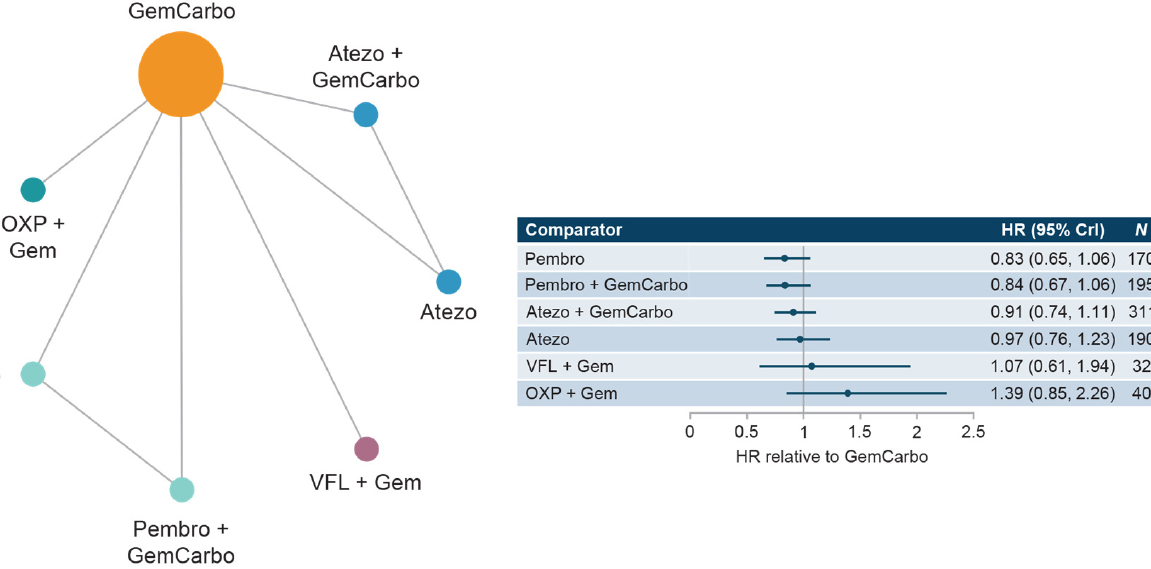
Figure 2. Network diagram and HR for OS by treatment network for the cis-ineligible (wide) net- work. Abbreviations: Atezo, atezolizumab; cis, cisplatin; CrI, credible interval; Gem, gemcitabine;